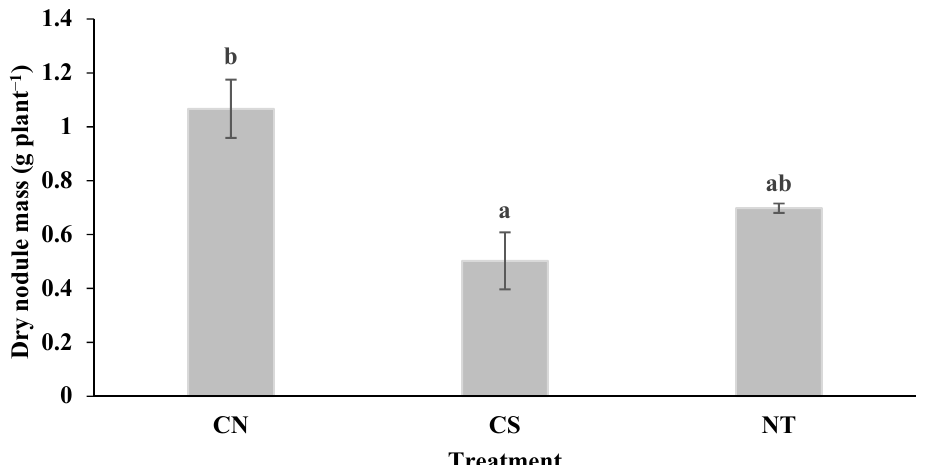
Figure 4. Soybean dry nodule mass production per plant according to the different tillage systems (CN, conventional; CS, conservation; NT, no-tillage). Data are the means ± standard error. Different letters (a, b, ab) indicate significant differences ( p ≤ 0.05, Tukey’s tests) among treatments.